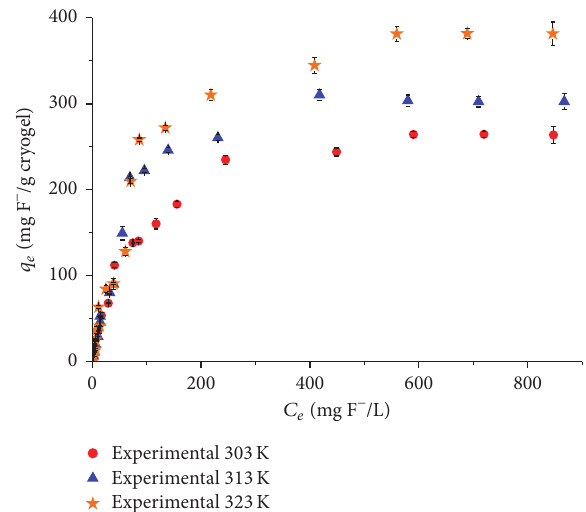
Figure 13: Sorption isotherms, cryogel QEFe, 8 mL, 24 hours of contact, 200 rpm, 0.002 g cryogel mass, pH 6, closed atmosphere.